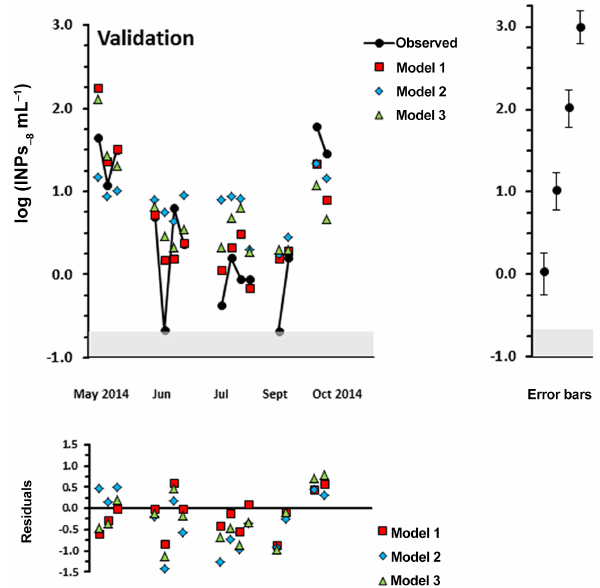
Figure 3. Comparison of observed concentrations of INPs − 8 with the values predicted by models (absolute values in upper pan- els, residuals in lower panels) for the data set used for validation ( n = 15). The grey area in the upper panel indicates the range be- low the detection limit of our observation method. Time proceeds from left to right, intervals are not to scale, dots belonging to the same sampling campaign are connected by lines. Error bars associ- ated to the measurement of 1, 10, 100, and 1000 INPs − 8 mL − 1 are represented close to the